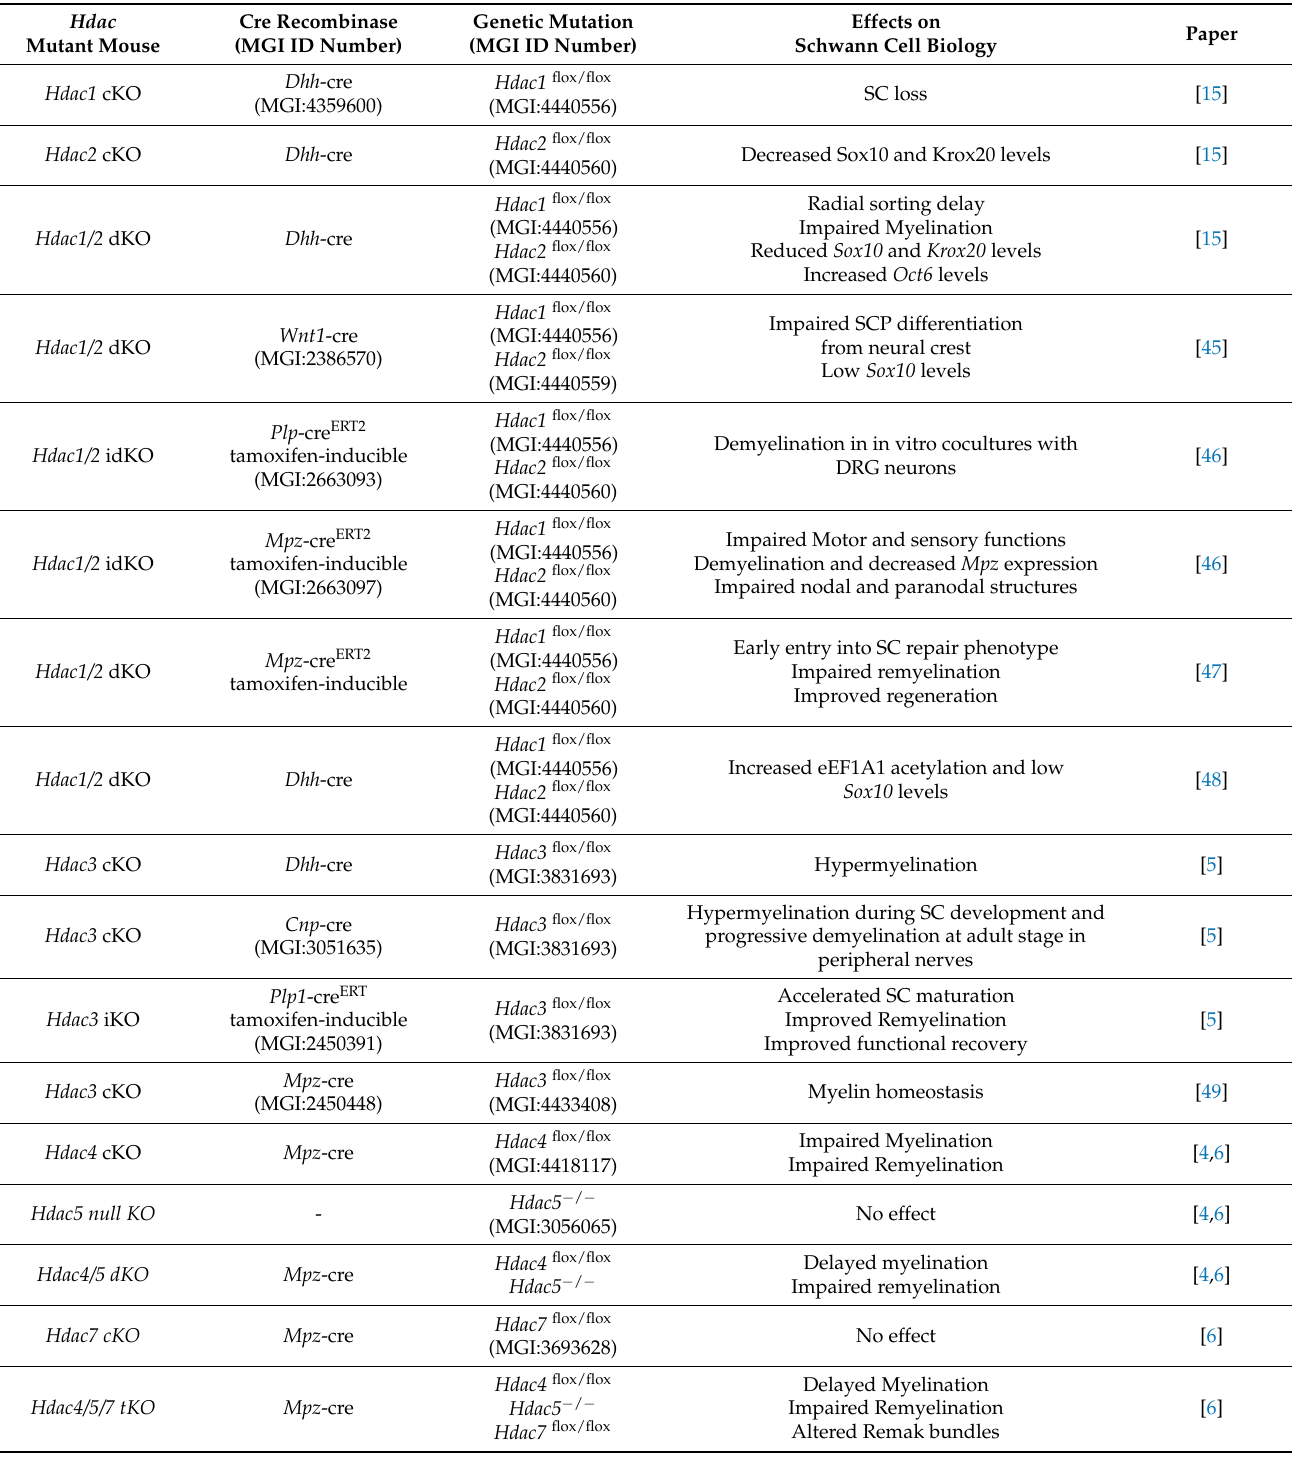
Table 1. Conditional or tamoxifen inducible knockout mice used to study the role of HDACs in Schwann cells (SCs). MGI ID number from the Mouse Genome Informatics (http://www.informatics. jax.org/) (Accessed on 26 February